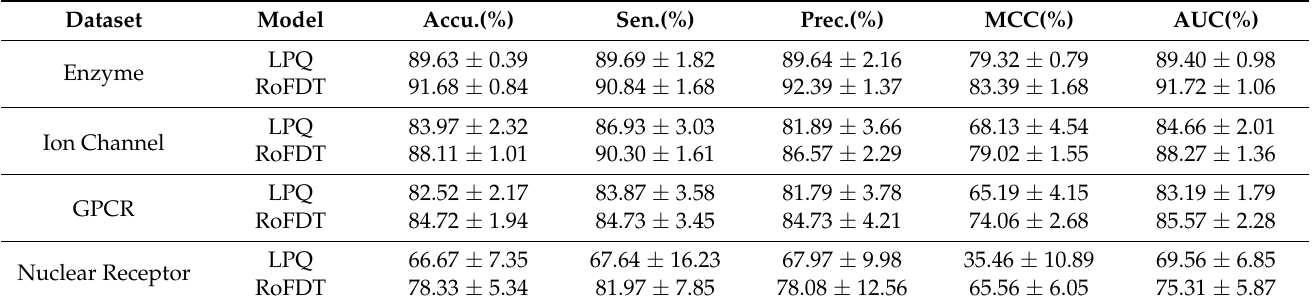
Table 5. 5FCV outcomes of the LPQ combined with FwRF model on the four gold standard datasets.